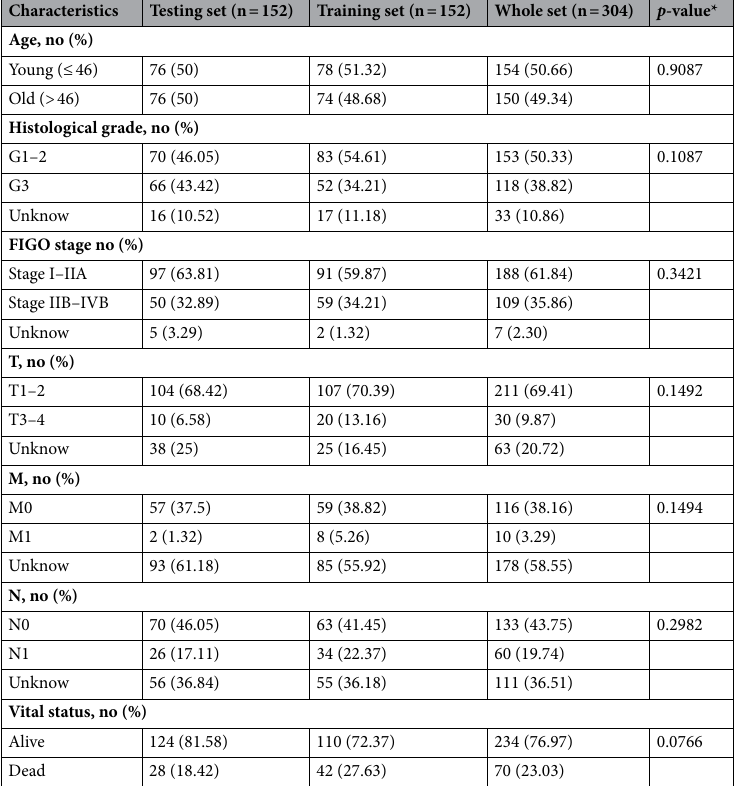
Table 1. Clinical information for 3 cervical cancer patients sets in this study. *Compared testing set with training set by using Chi square